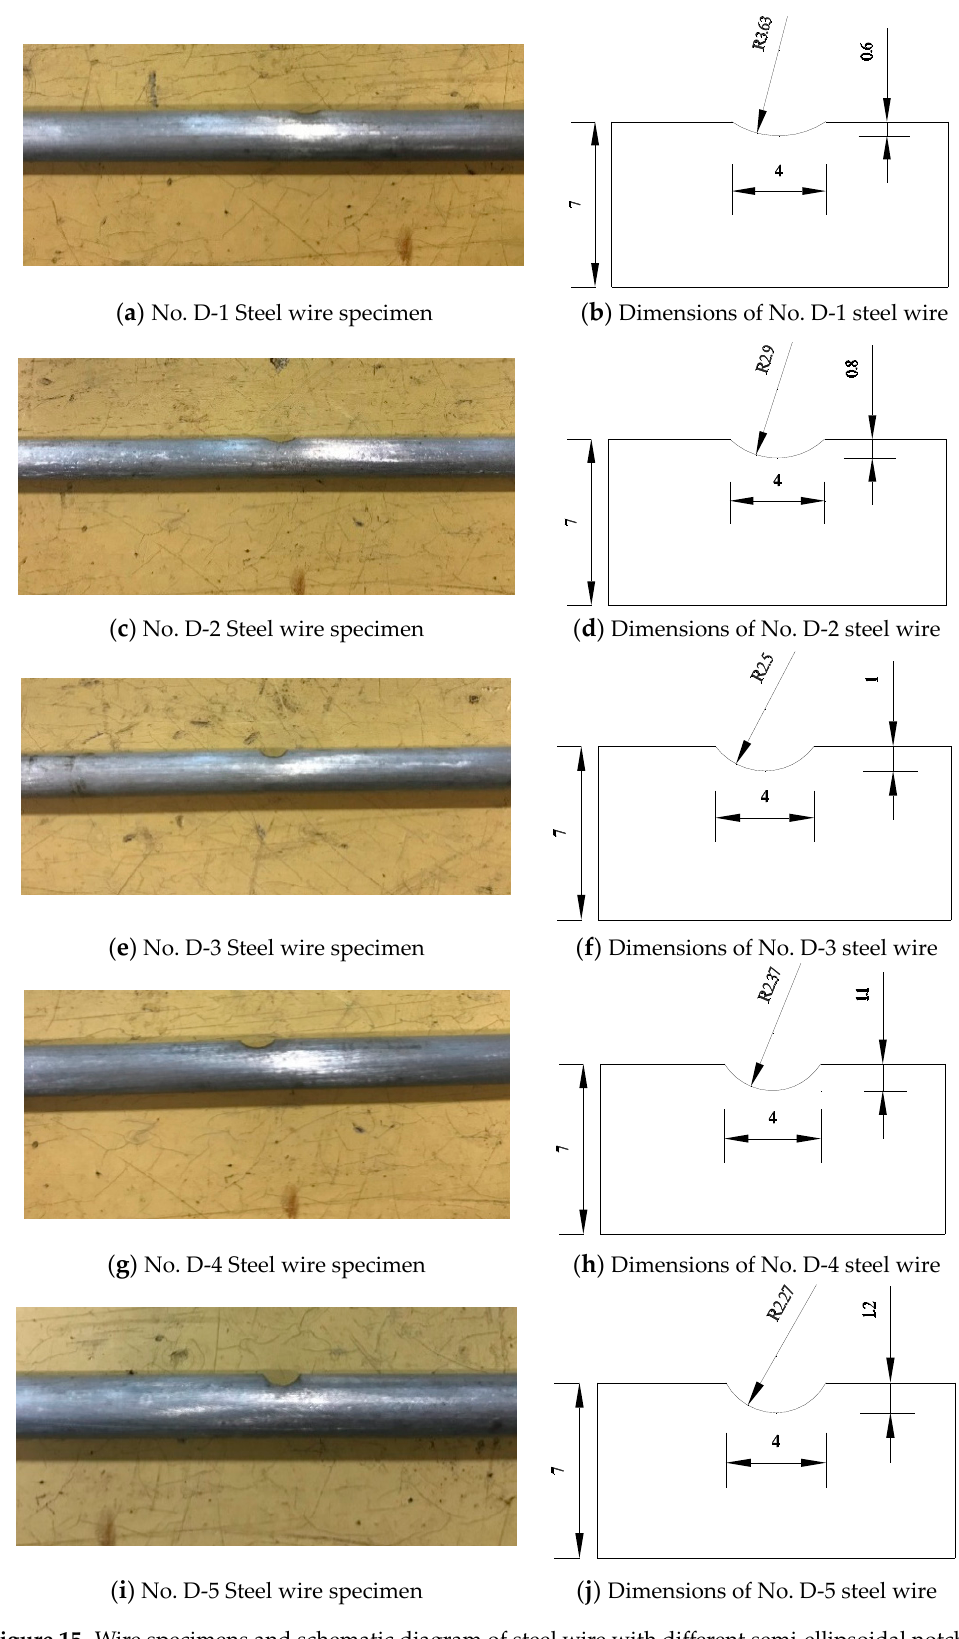
Figure 15. Wire specimens and schematic diagram of steel wire with different semi-ellipsoidal notches of different widths.